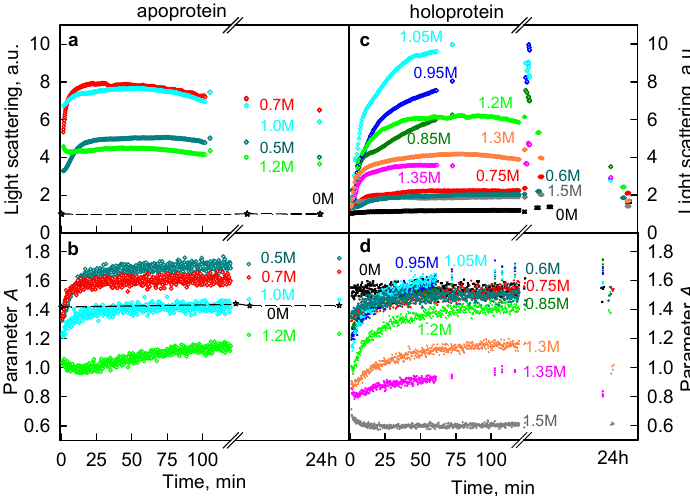
Figure 5. Kinetic traces of GTC-induced unfolding of iRFP713 in the apoform and holoform. ( a , c ) Changes in the light scattering of the apoform and holoform, respectively. ( b , d ) Changes in the parameter A = I 320 / I 365 of the apoform and holoform, respectively. The excitation wavelength is 295 nm. Numerals at the curves specify applied GTC concentration.